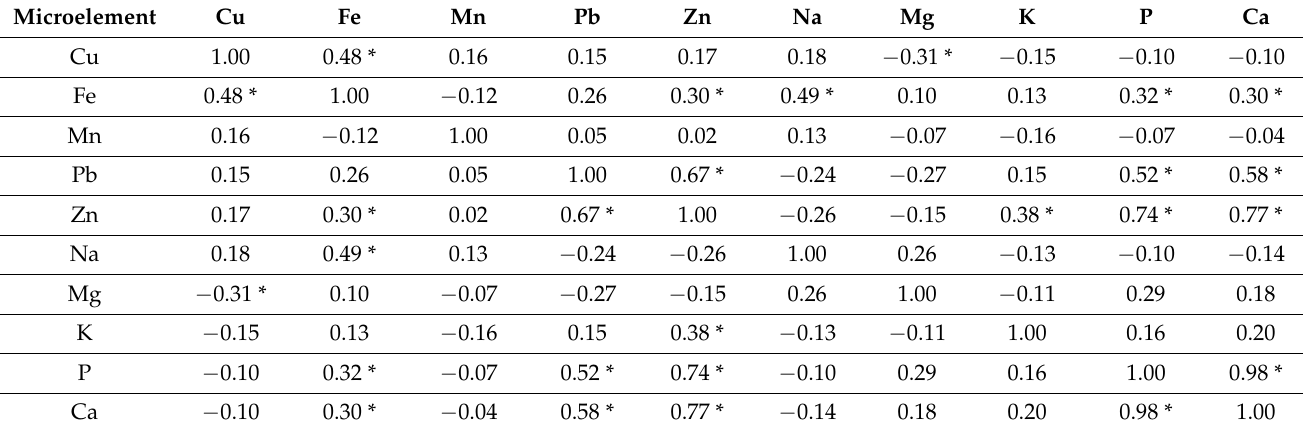
Table 8. Correlationsbetween the individualconcentrations of elementsin degeneratedintervertebral discs.